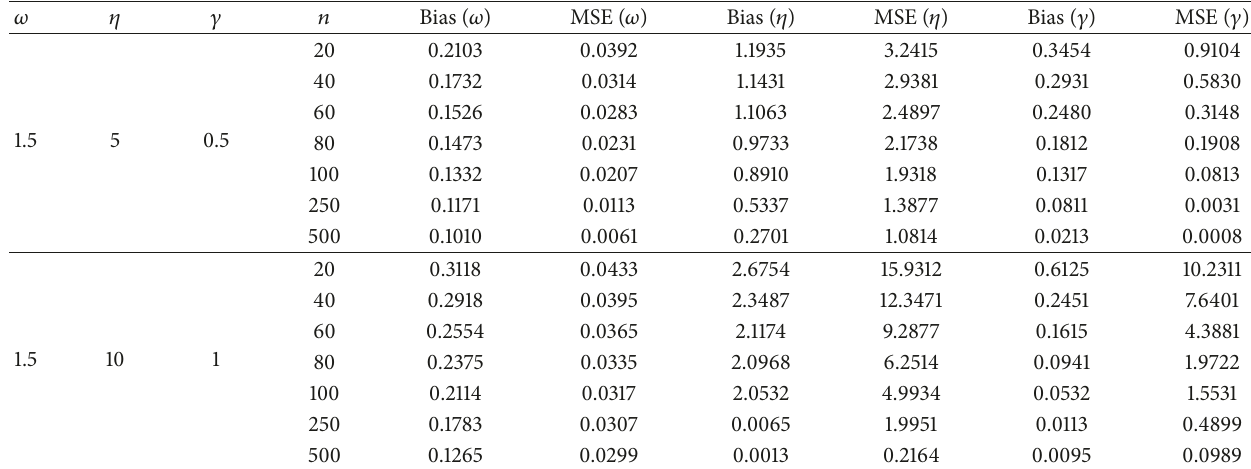
Table 2: Bias and MSE for the HLGW